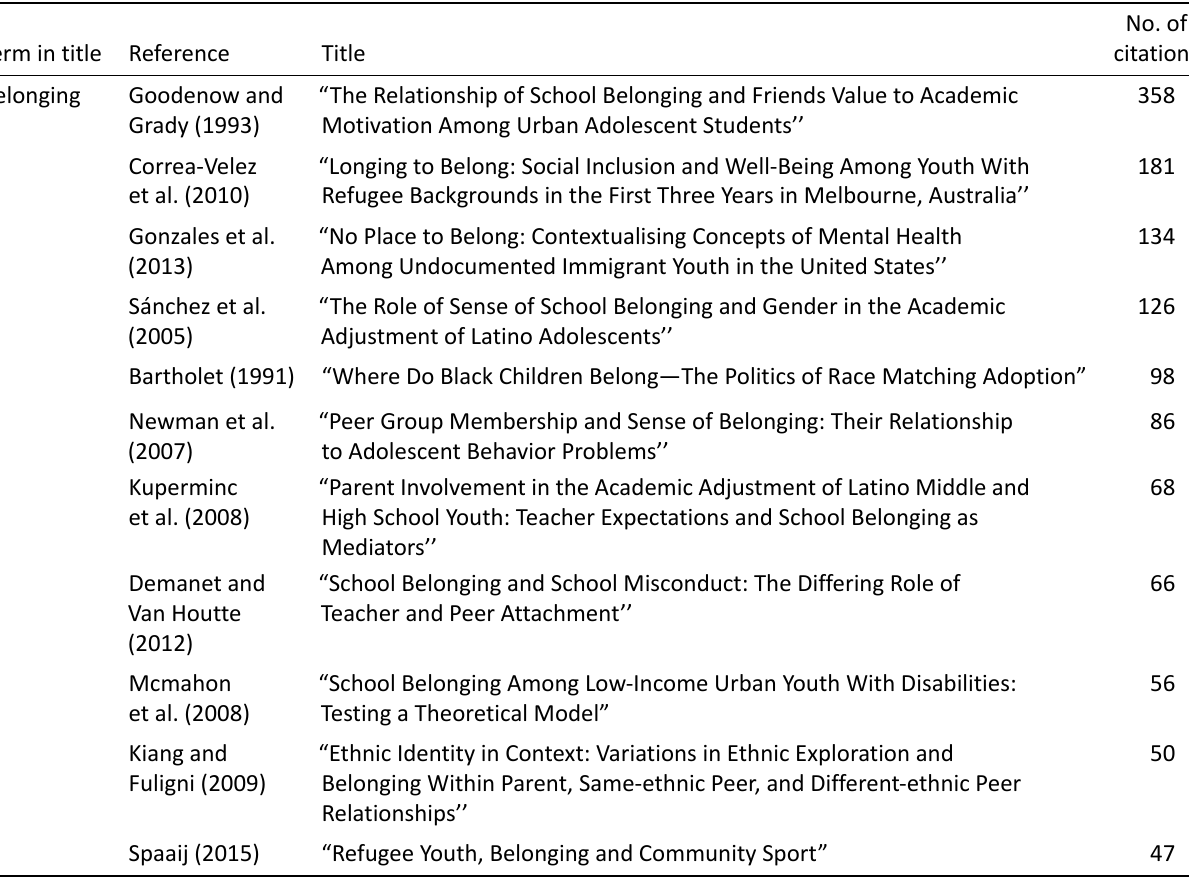
Table 2. Overview of articles addressing children with immigrant backgrounds (sample